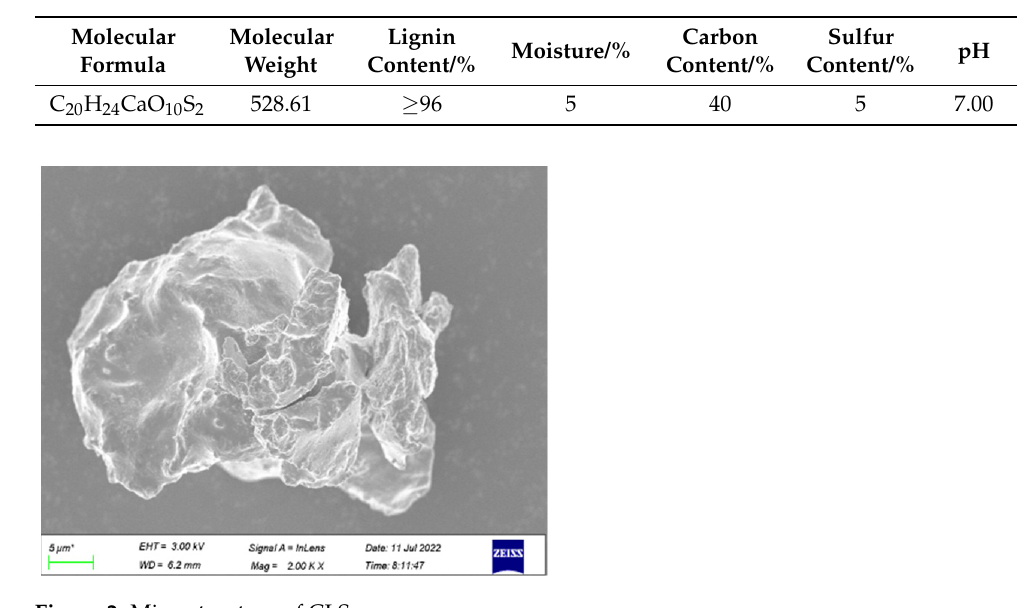
Figure 1. Calcium lignosulfonate (CLS) used in the test. Table 2. Composition of CLS in the test.